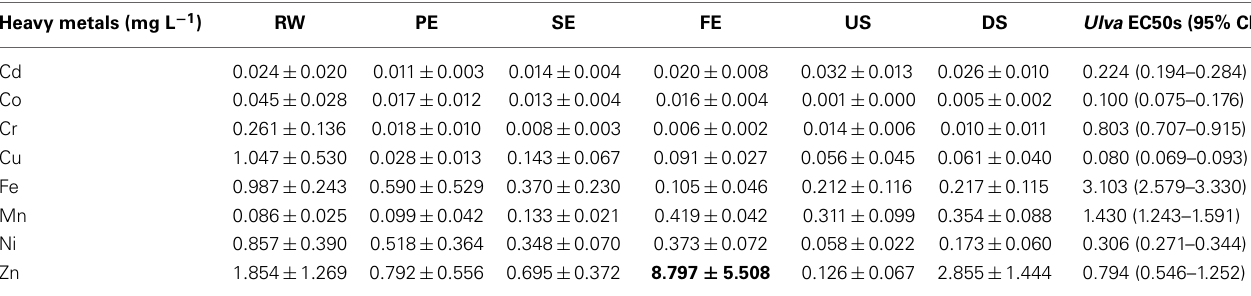
Table 2 | Mean and standard deviation of metal concentrations of WTP effluents and the adjacent stream water over a